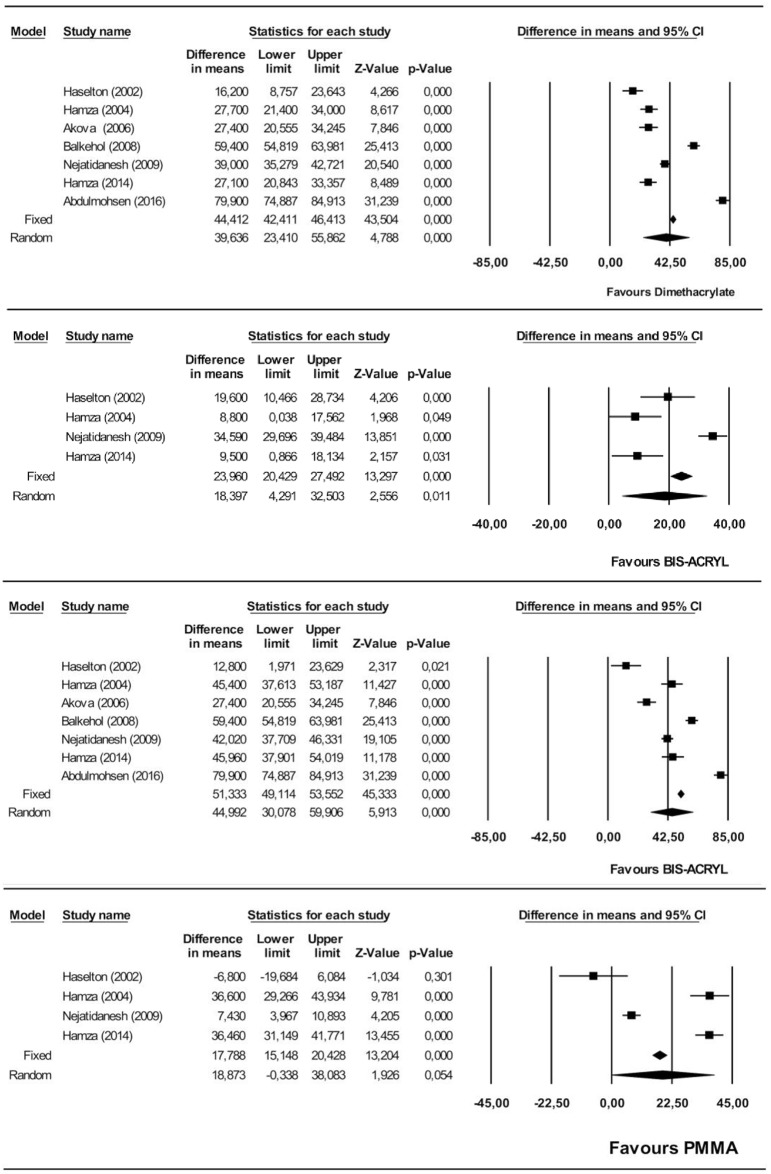
Forest plot of flexural strength.Flexural strength. Dimethacrylate vs. monomethacrylate groups (Fig 3A), Flexural strength. Bis-acryl vs. PMMA (Fig 3B), Flexural strength. Bis-acryl vs. PEMA (Fig 3C), Flexural strength. PMMA vs. PEMA (Fig 3D).